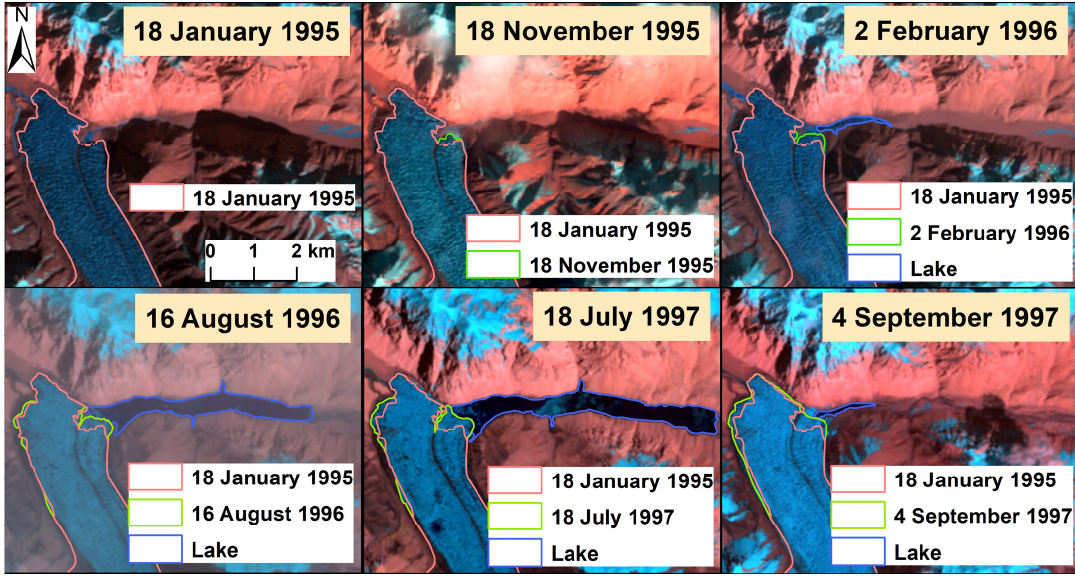
Figure 3. Glacier and glacial lake boundaries in di ff erent periods from 1995 to